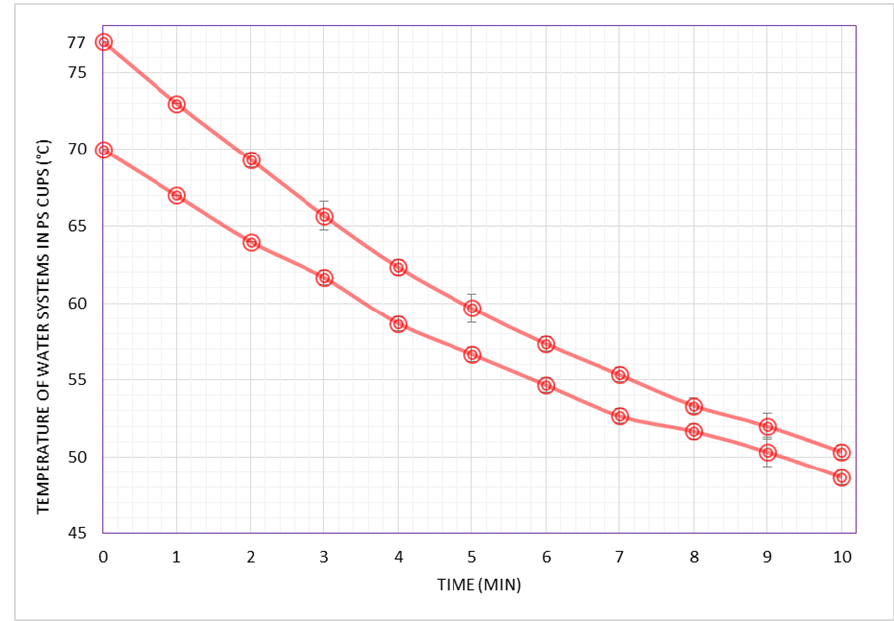
Figure 1. Cooling behaviors (temperature as a function of time) of hot water systems from 77 ◦ C and 70 ◦ C, both in disposable 50 mL polystyrene (PS) cups and at a constant ambient temperature of 30 ◦ C. Temperatures of the water systems were collected in one minute intervals up to 10 min. Point values are shown as the mean of 3 repetitions ± standard deviations of each experiment and the coe ffi cient of variation never exceeded 1.9%.